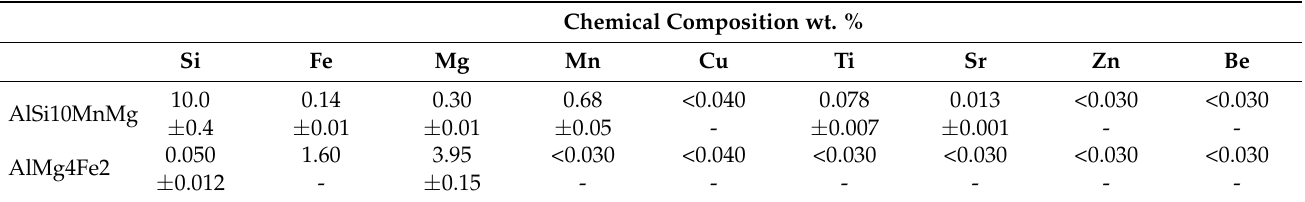
Table 1. Chemical composition of AlSi10MnMg and AlMg4Fe2 alloys (wt. %). Chemical Composition wt.